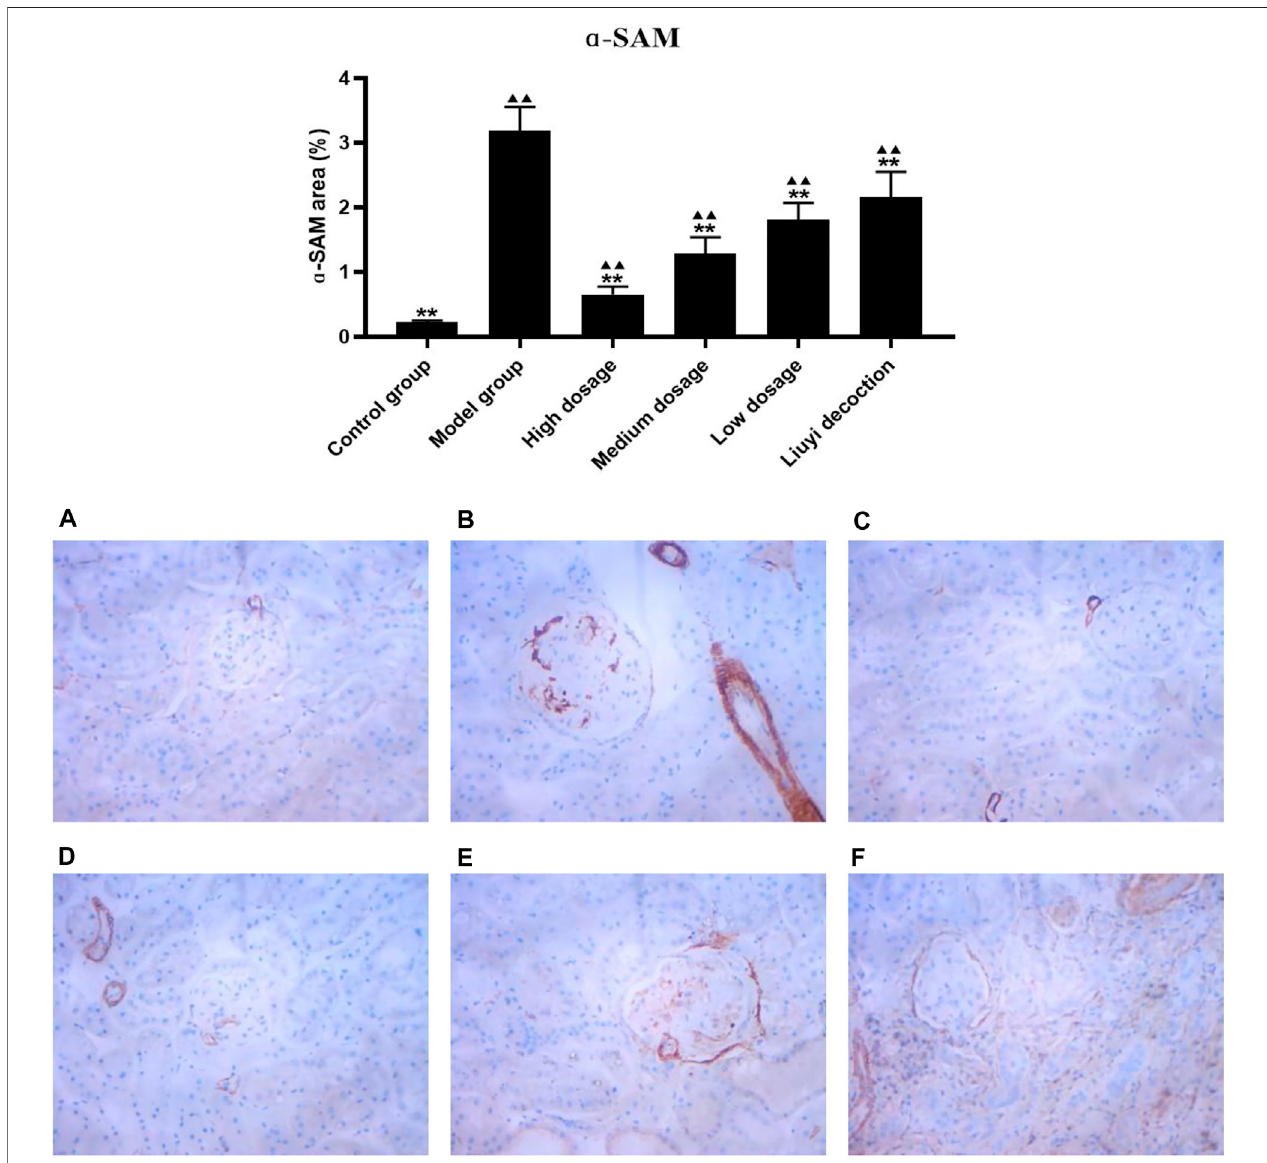
FIGURE 7 | Effect of HQD on the expressions of ɑ -SAM in kidney (×400). Control group (A) ; model group (B) ; high dosage (C) ; medium dosage (D) ; low dosage (E) ; Huangqi Liuyi decoction (F) . ps: vs. Model group, * P < 0.05, ** P < 0.01; vs. control group, ▲ P < 0.05, ▲▲ P < 0.01 (x±SD, n =6).